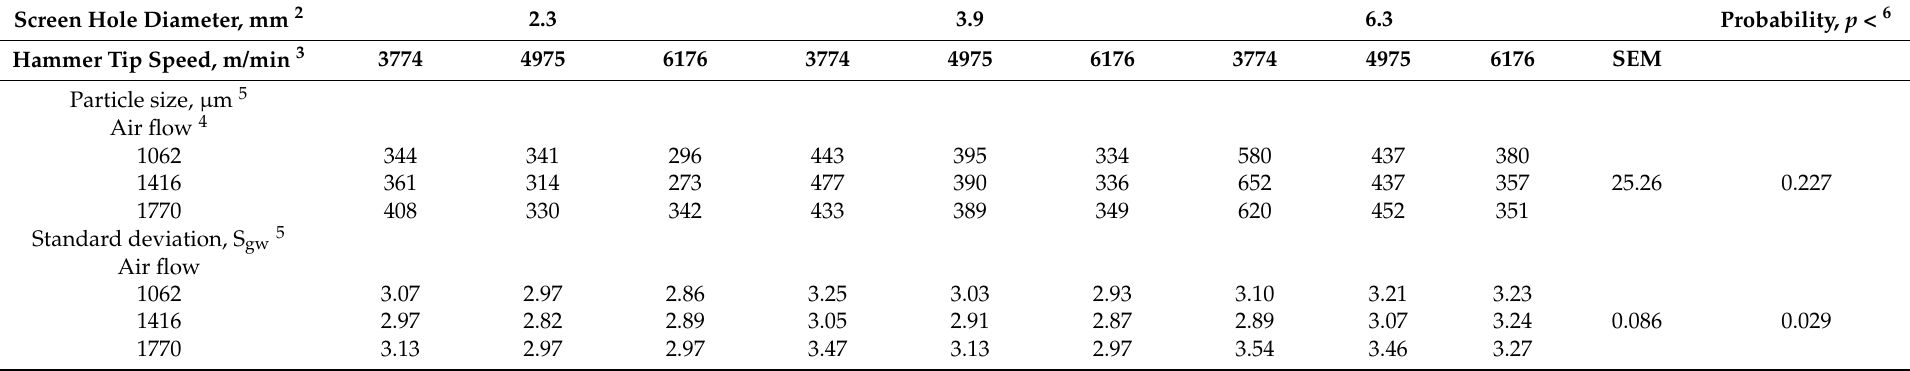
Table 1. Influence of 3-way interaction of screen hole diameter × hammer tip speed × air flow on the particle size and standard deviation of hammermilled corn 1